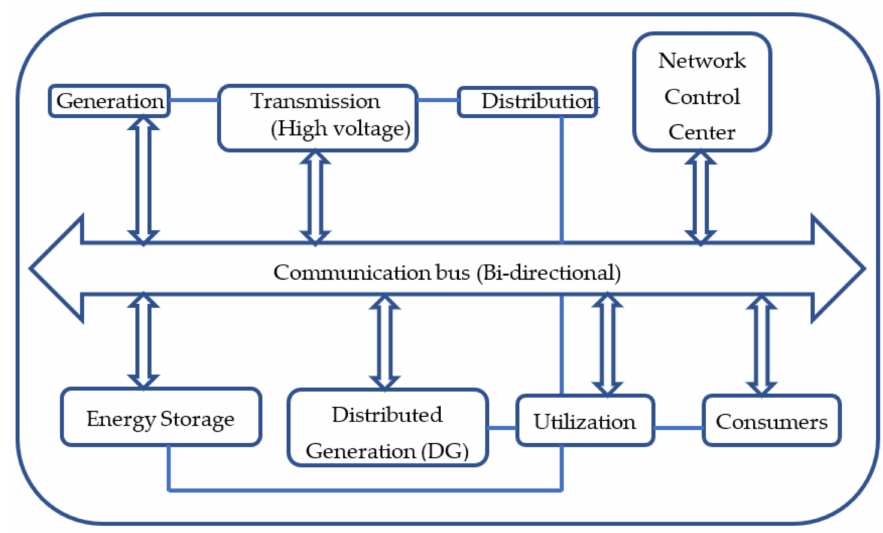
Figure 1. Schematic of a Smart Grid.